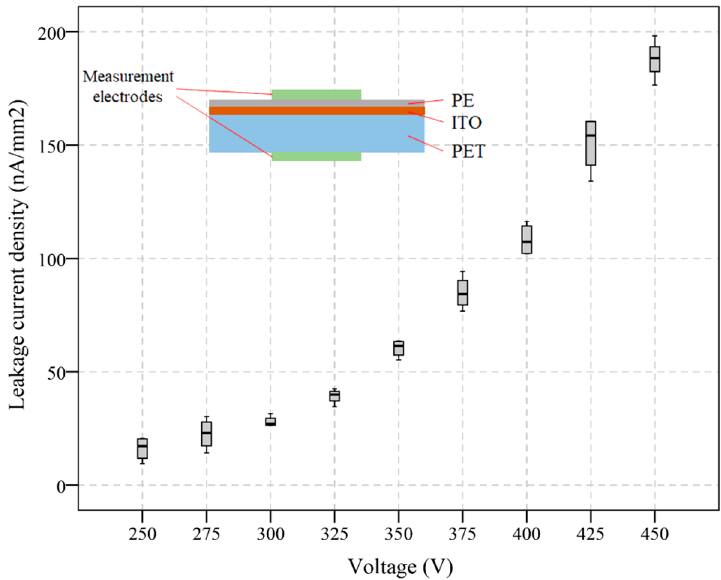
Figure 8. Leakage current density across the fabricated digital microfluidic device.